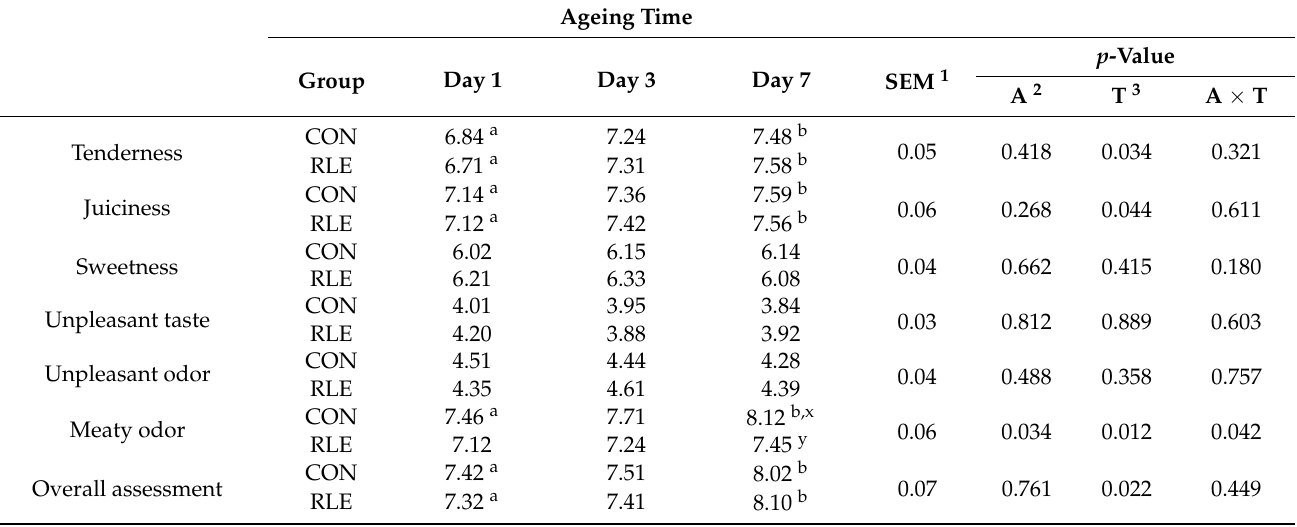
Table 8. Effects of anthocyanin diet addition and ageing on sensory evaluation of meat from goat kids ( n = 30 samples for each experimental